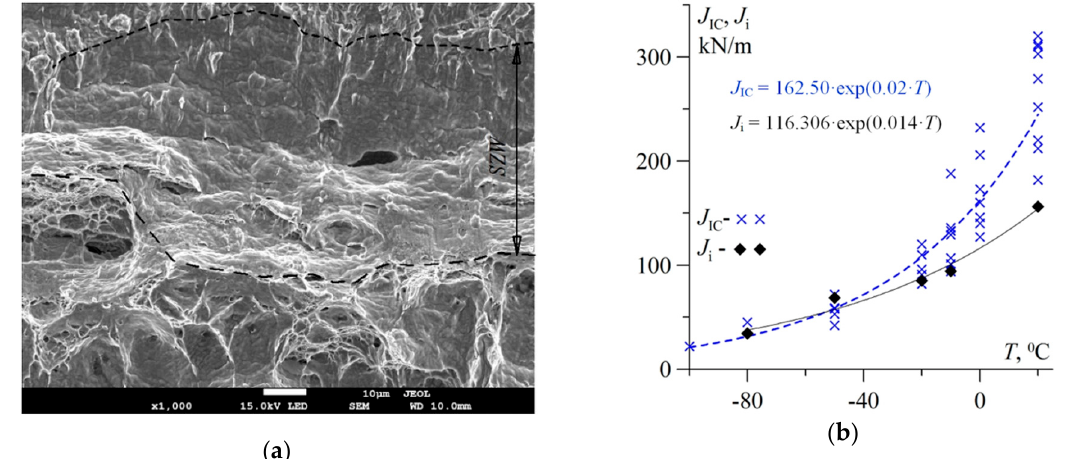
Figure 11. ( a ) A stretch zone view; ( b ) a comparison of the critical values of the J IC and J i .